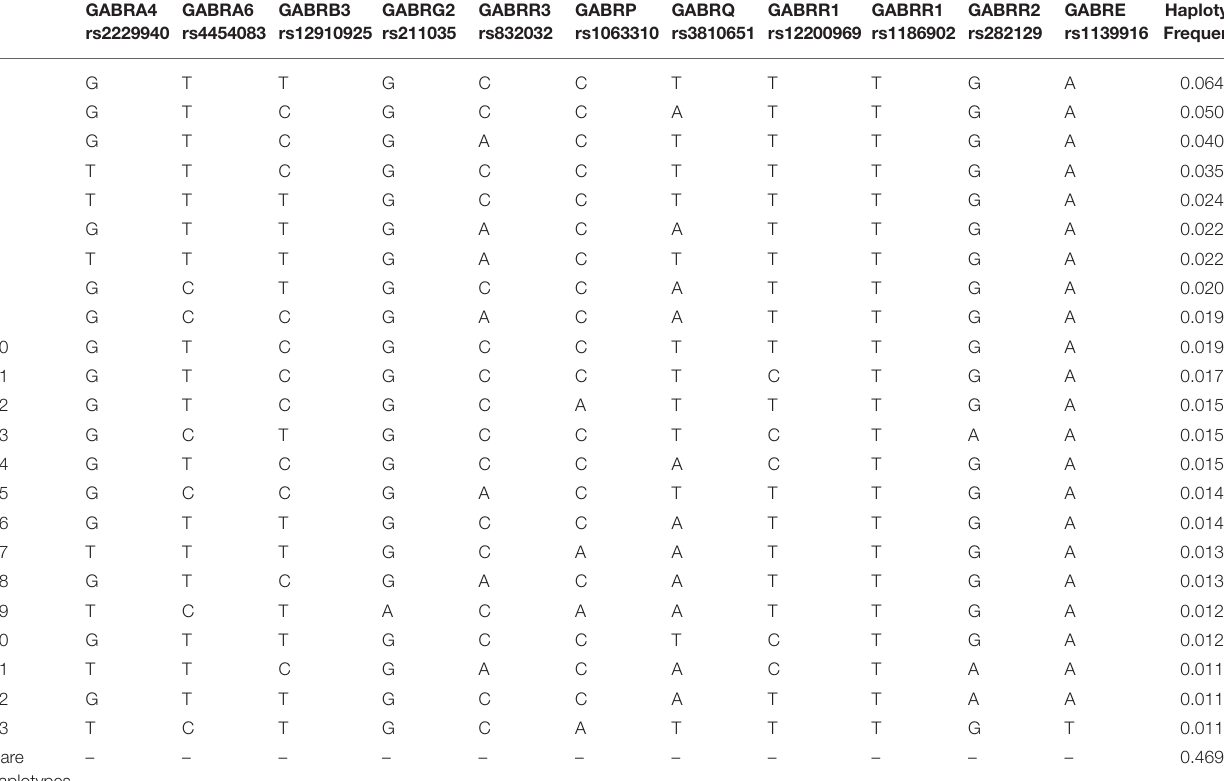
TABLE 5 | GABR haplotypes in the whole study